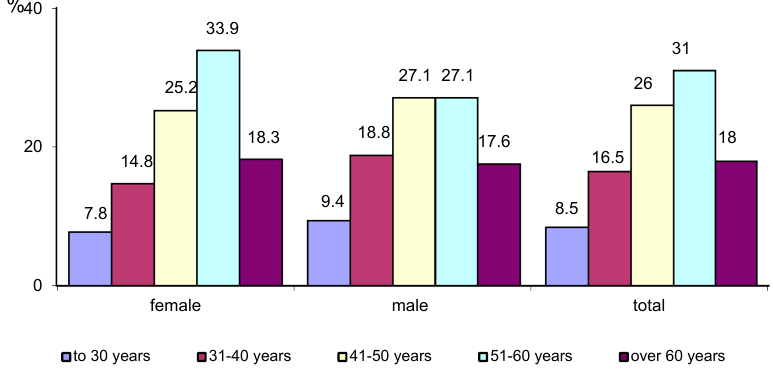
Figure 1. Age groups breakdown depending on sex.